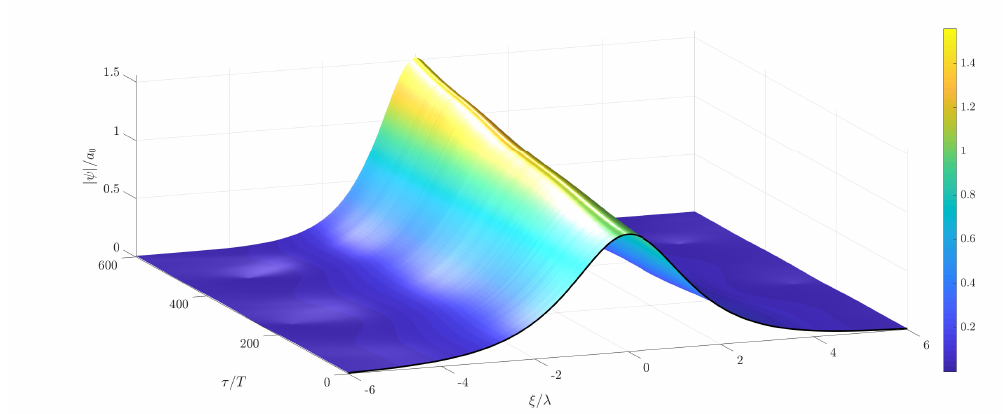
Figure 6. Temporal evolution of a soliton solution of the stochastic NLS with non-white noise excitation in time, mean wind velocity V m = 14 m/s and σ v = 1 m/s.